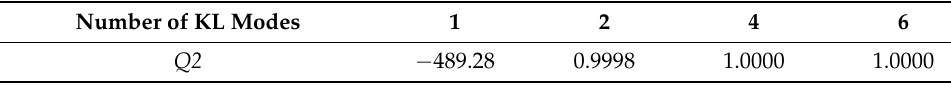
Table 1. Predictivity factor Q2 as a function of the number of KL